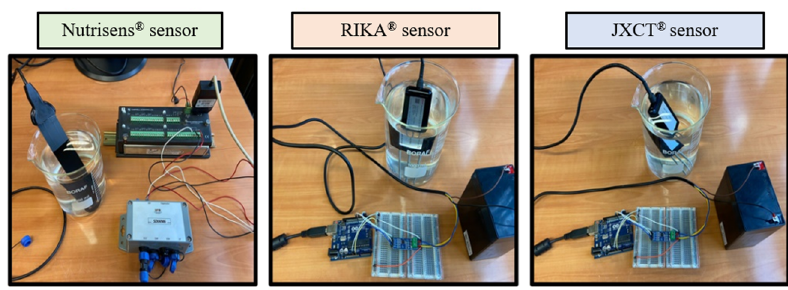
Figure 4. Experimental set-up of the three probes in nitrate dissolutions.